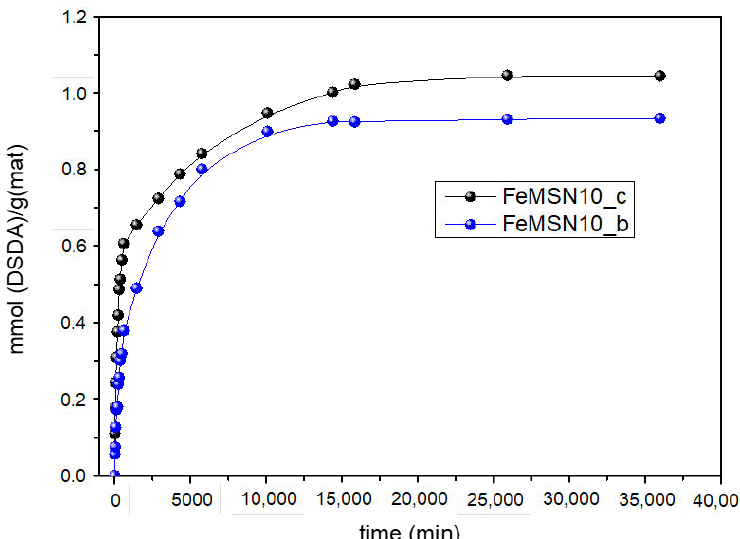
Figure 8. DSDA release as a function of time from the Fe 3 O 4 @MSNs synthesised.